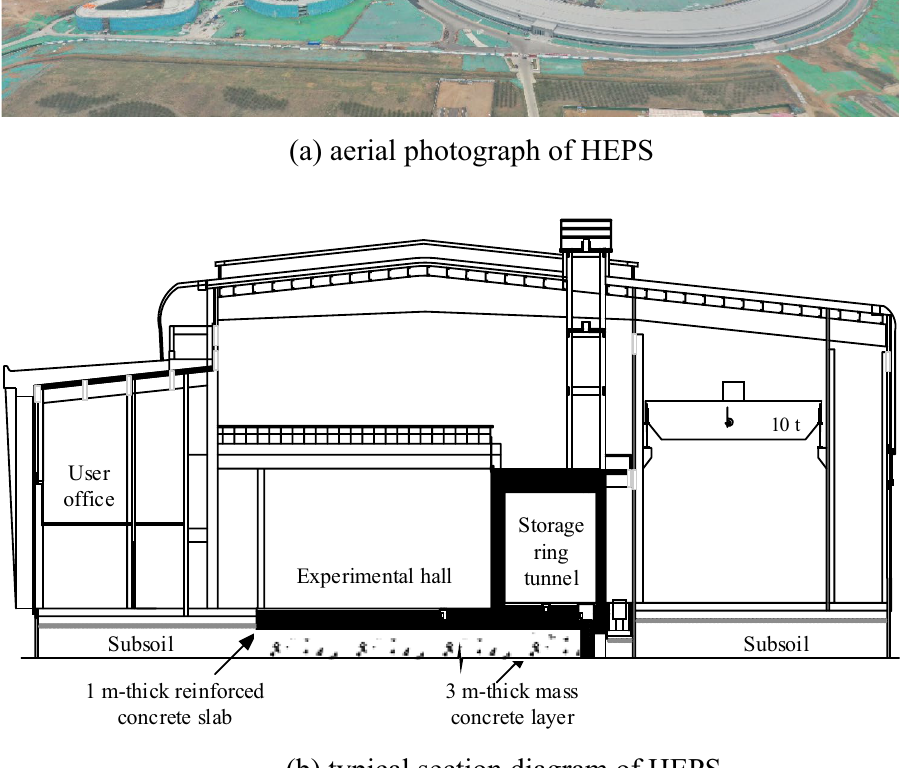
Figure 1. High Energy Photon Source in Beijing (under